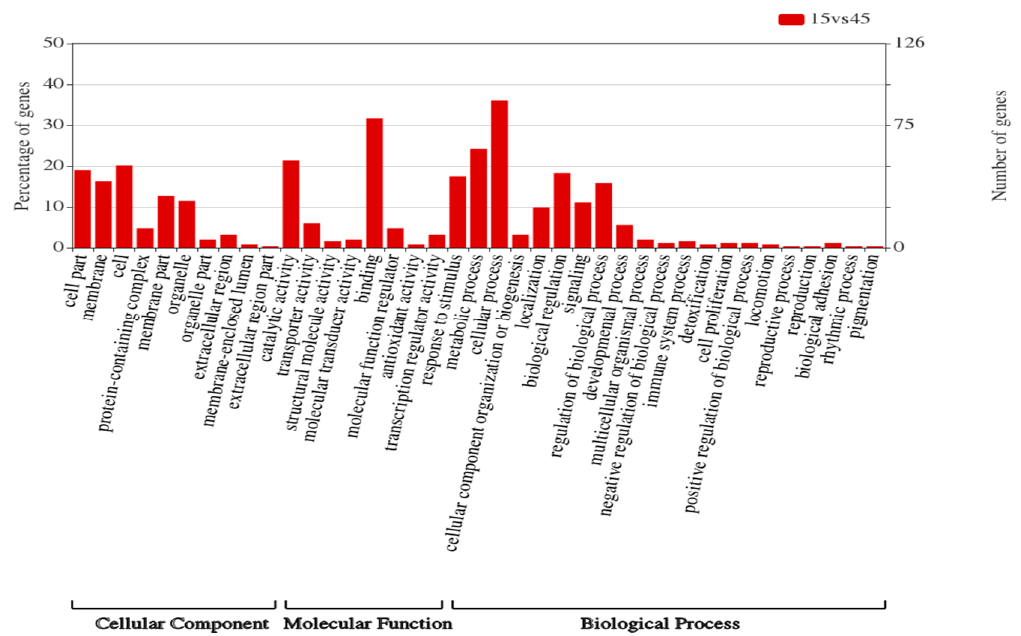
Figure 2. Results of the enrichment analysis of gene ontology (GO) terms of differentially expressed genes (DEGs) of A. ommaturus exposed to salinity changes.